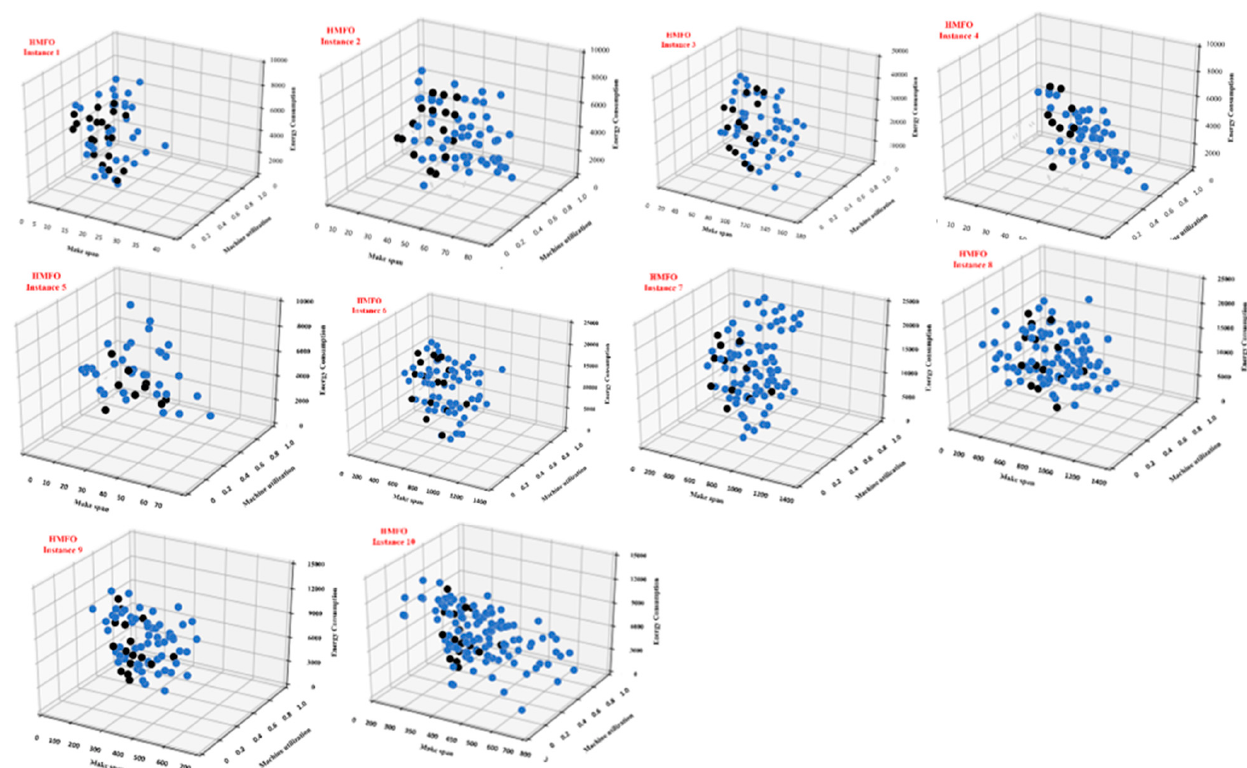
Figure 16. Pareto optimal graphs showing various solutions for three objectives makespan, energy consumption, and machine utilization for HMFO algorithm.